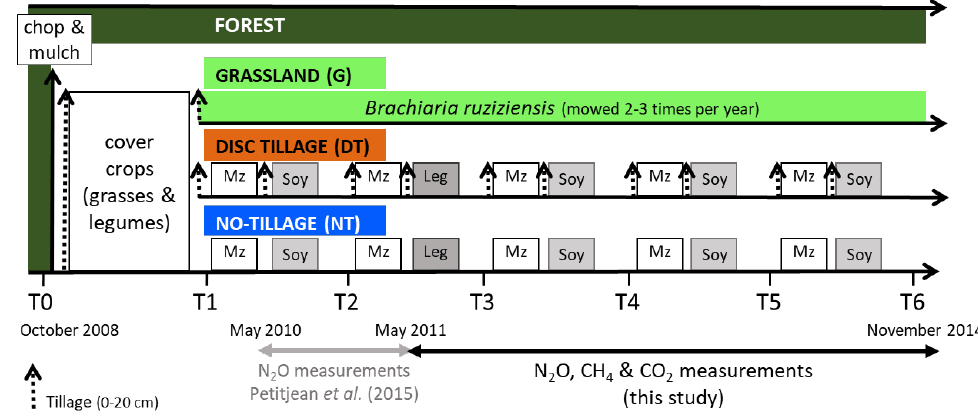
Figure 1. History of the Combi experimental site (French Guiana) from October 2008 to November 2014. After deforestation and one year with legume and grass cover, three agricultural systems were set up: Grassland (G) and croplands (maize/soybean rotation) with either disc tillage (DT) or no-tillage in direct seeding (NT). Mz = maize, Leg = legumes, Soy = soybean.